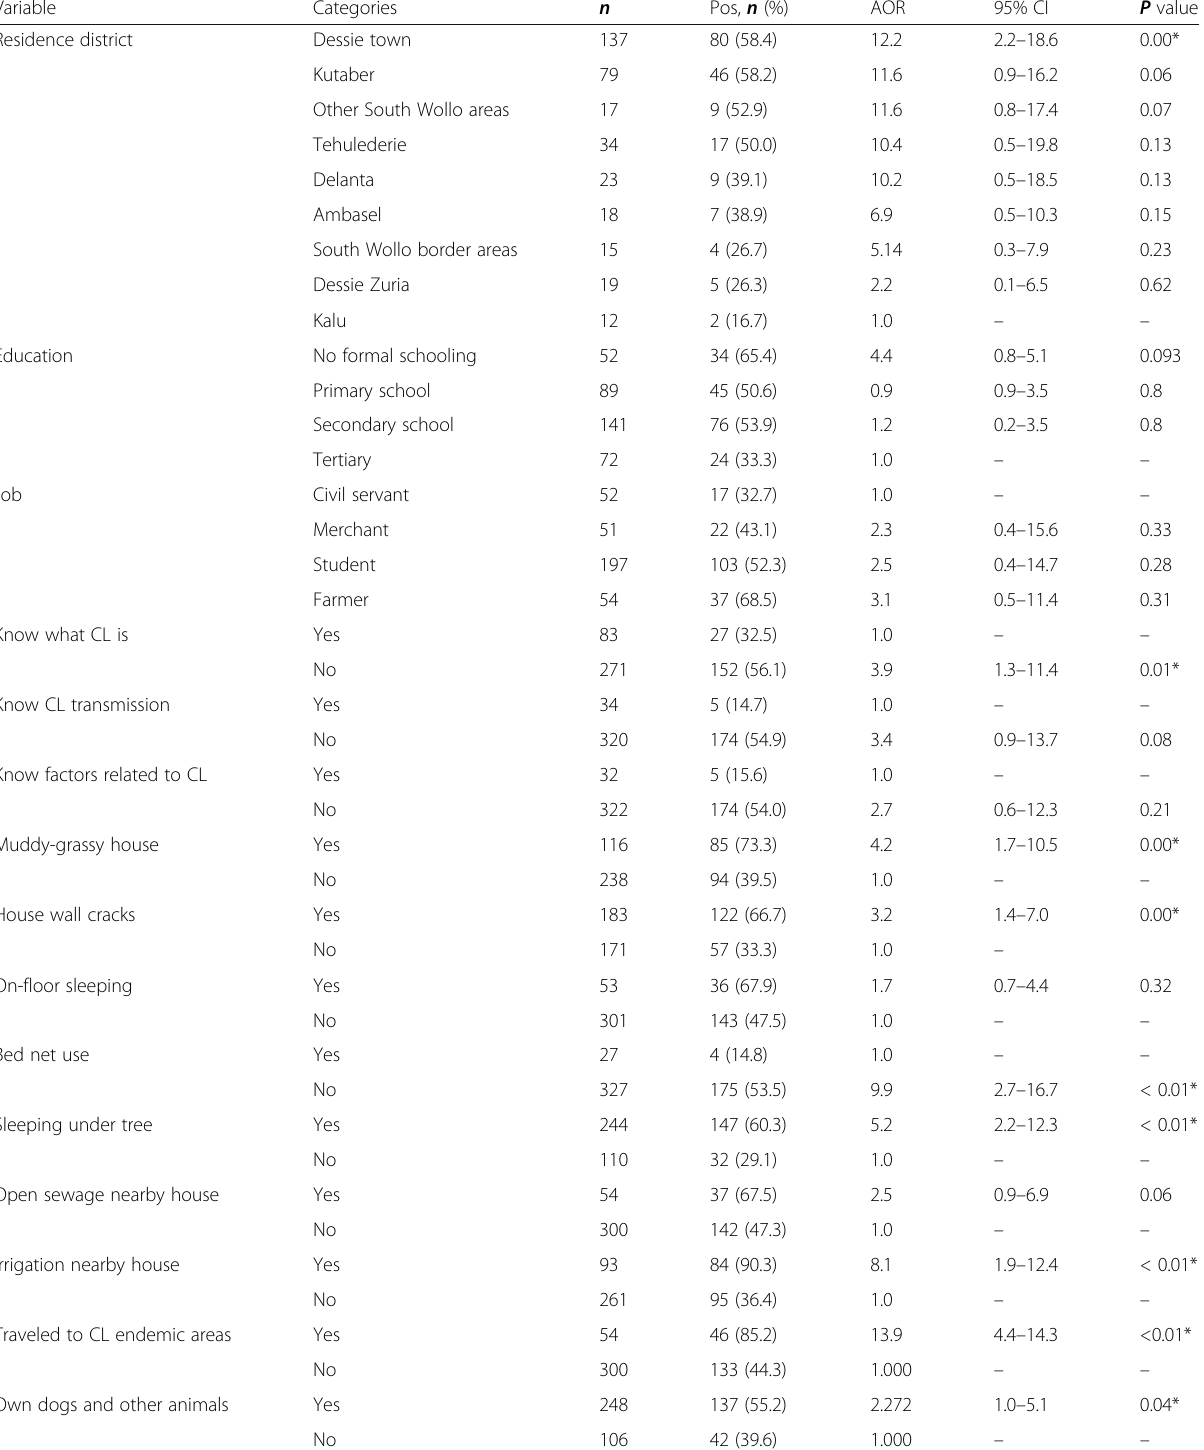
Table 5 Multivariable logistic regression analysis result of risk factors for CL positivity at BMH, Dessie town, north-central